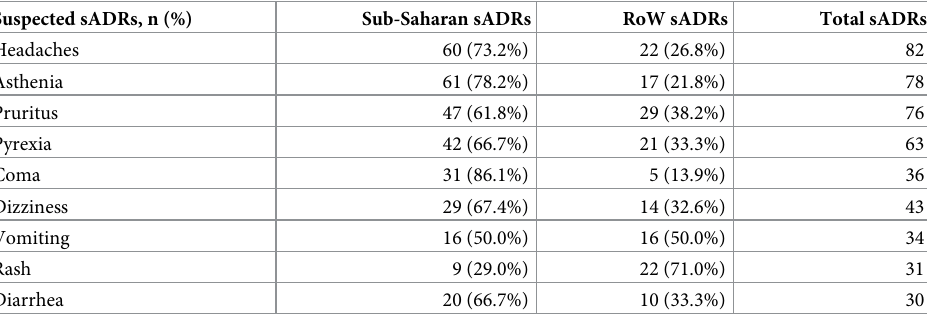
Some of these results were expected, given the different mechanisms of action of ivermectin and benzimidazoles on the various targeted parasites. Ivermectin exerts a strong microfilarici- dal effect on filariae, leading to a destruction of mf within one week after treatment. In subjects Table 4. Frequency of ten most reported suspected sADRs by regions and in